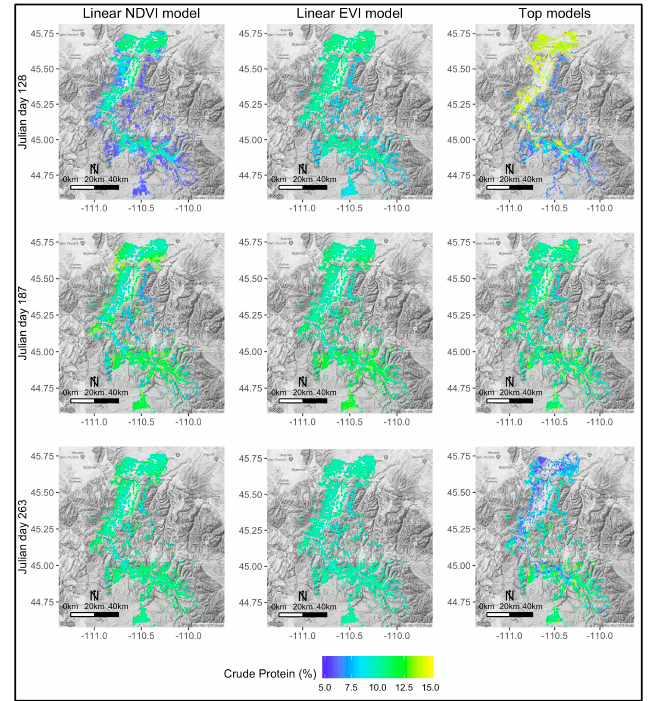
Figure 7. Maps of the crude protein (%) of grasslands across the Upper Yellowstone River Basin on Julian days 128, 187, and 263 estimated from the linear NDVI, linear EVI, and the top models.